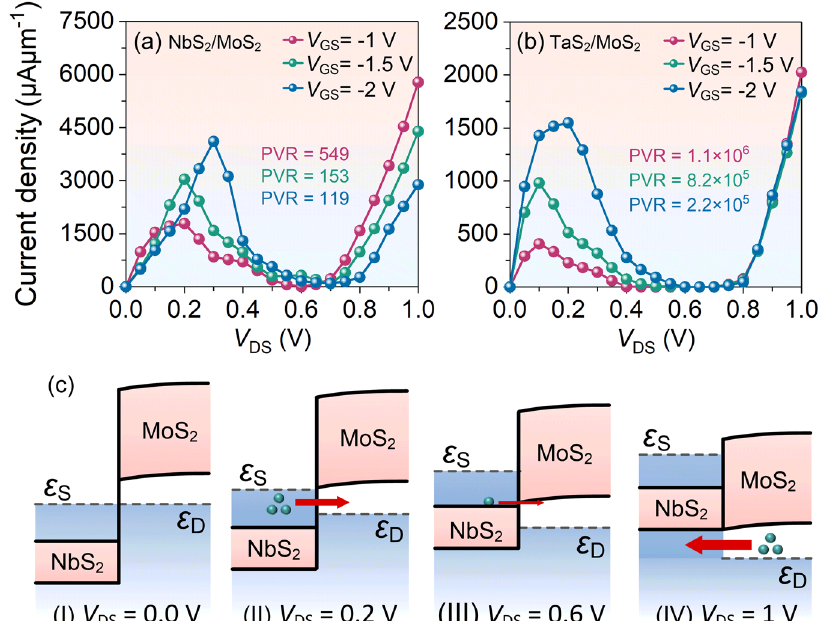
Fig. 5 The output I-V curves and NDR mechanism of CM-FETs. a, b The I-V curves of NbS 2 /MoS 2 and TaS 2 /MoS 2 CM-FETs. PVR labelled in ( a, b ) is the ratio of the peak current and valley current. ( c ) Energy band diagrams under different bias voltages ( V DS ) at V GS = -1 V. The pink areas in ( c ) represent gaps of NbS 2 /MoS 2 heterojunction. The ε S and ε D are the Fermi level of source and drain, respectively. The width of red arrows represents the magnitude of currents.